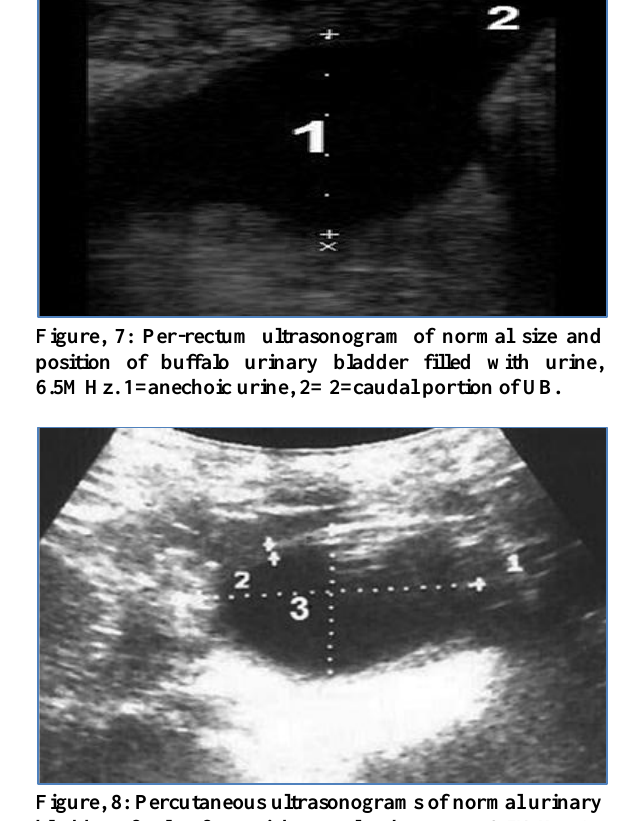
Table, 3: Right and left kidney ultrasonographic measurements (Mean±SD) of normal buffalo calves kidney Sites for